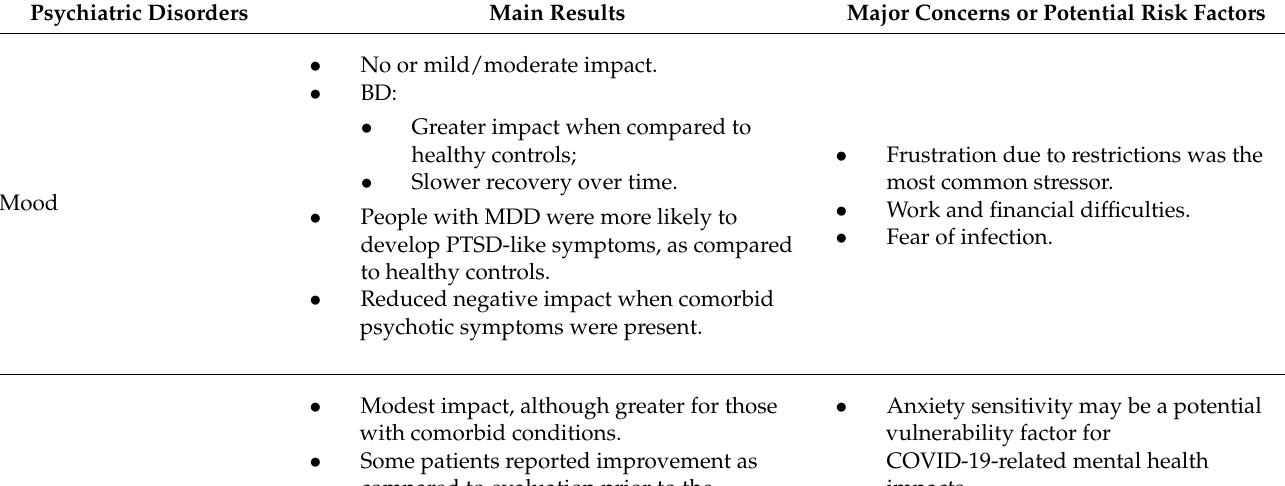
Table 4. Summary of main